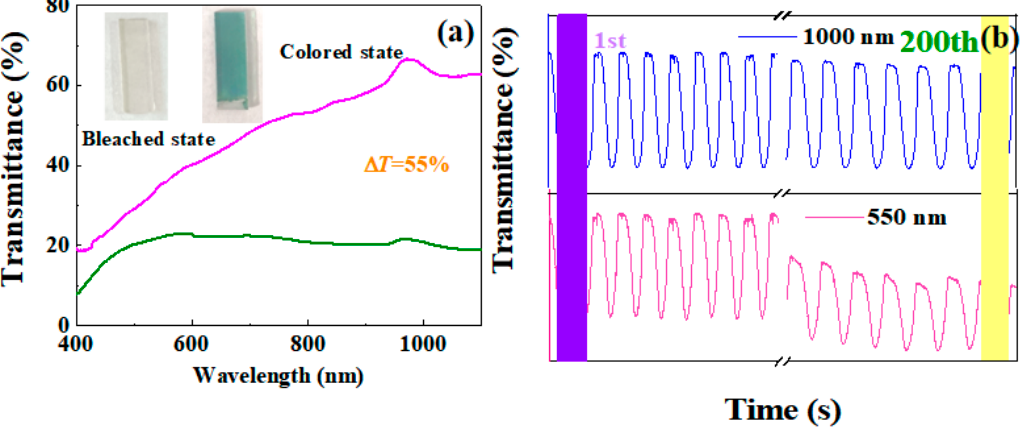
Figure 9. Electrochromic properties of TiO 2 /ZnO/FTO thin films. ( a ) Visible–near-infrared transmittance spectra of the bleached and colored TiO 2 /ZnO/FTO films, illustrated by corresponding photographs of 1 × 4 cm 2 TiO 2 /ZnO/FTO electrodes; ( b ) 200 cycles of TiO 2 /ZnO/FTO films at 550 nm and 1000 nm, respectively.